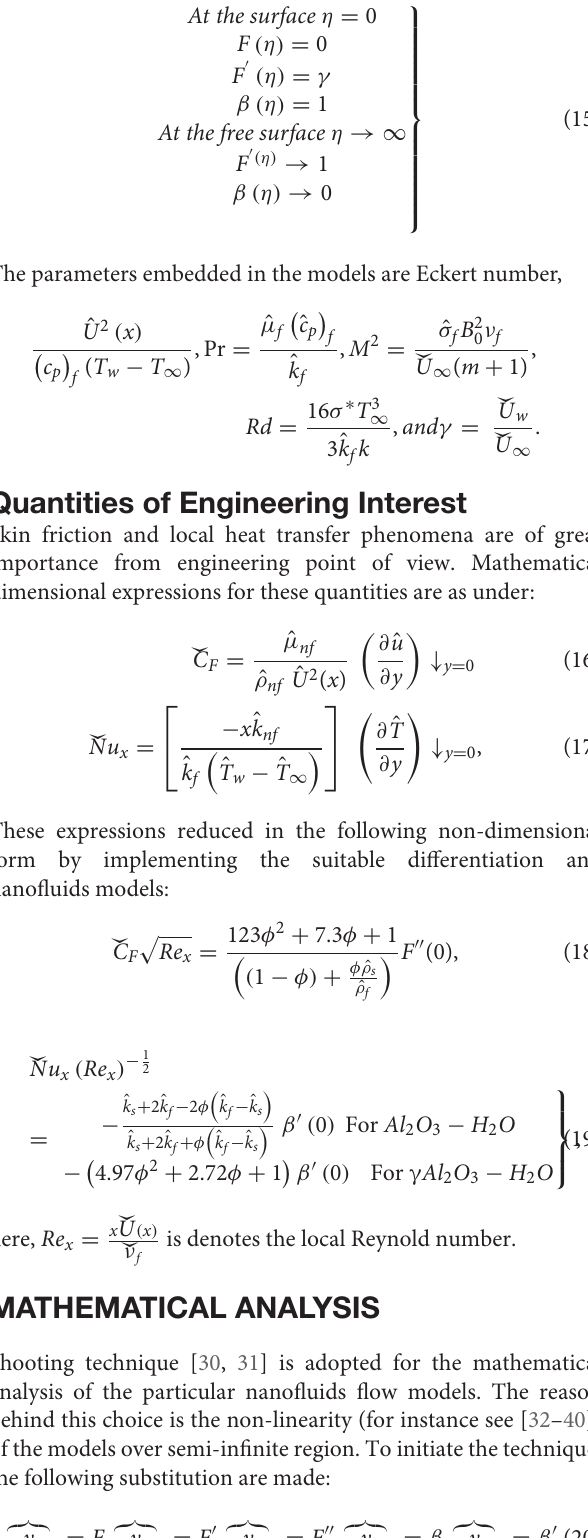
The conditions at the boundaries at the surface and at the free stream are as under: At the surface η =